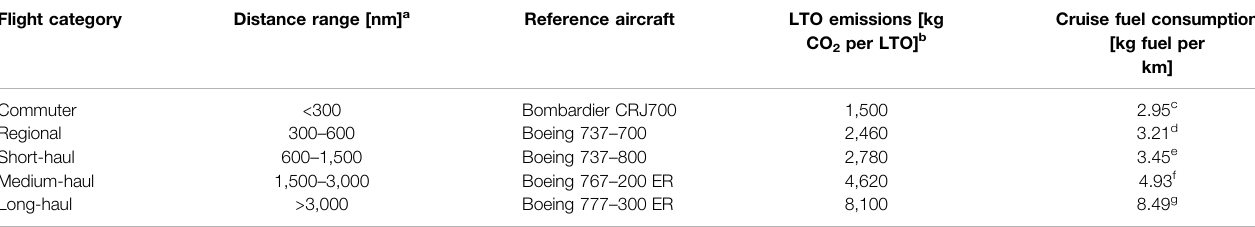
TABLE2| Flightcategories,referenceaircraftandtheirperformance.Flightsaredividedinto fi vecategoriesbasedon fl yingdistance.Anaircraftmostfrequentlyusedineach fl ight category is called a reference aircraft. All fl ights within the same fl ight category are assumed to be operated by the reference aircraft. Flight